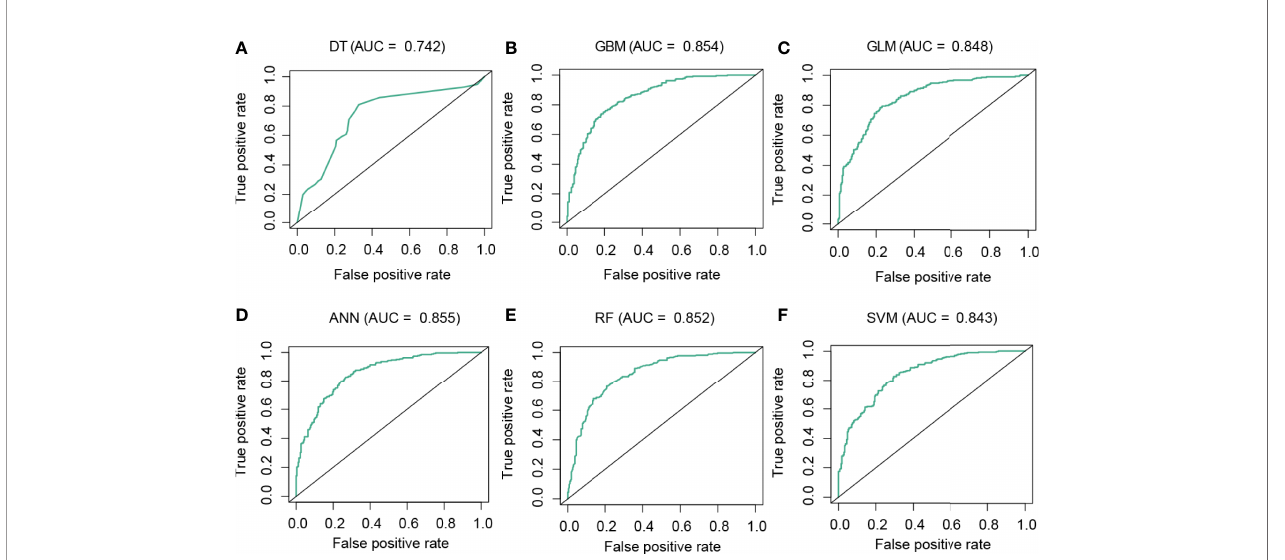
FIGURE 5 | Performance analysis of the models in the test dataset. ROC curve analysis of the performance of DT (A) , GBM (B) , GLM (C) , ANN (D) , RF (E) , and SVM (F) .